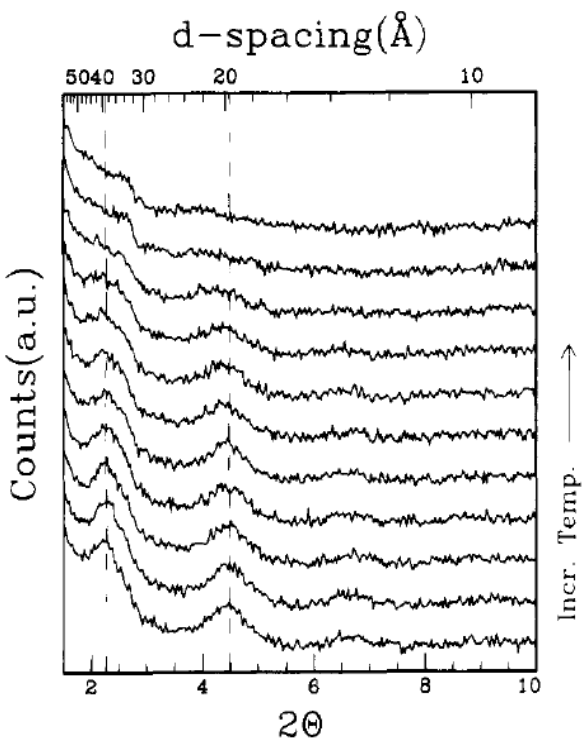
Figure 21. X-ray diffractograms of filler/DGEBA/benzyldimethlyamine system at different temperatures from 20 °C to 150 °C. Reproduced from reference [86] with permission from American Chemical